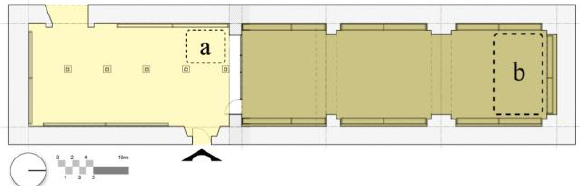
Figure 20. Architectural plan of the exhibition room. a.- Photogrammetry Station; b.- VR Booth.